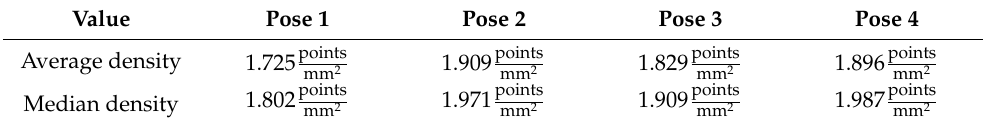
Table 7. Density evaluation statistics for different poses of a human.